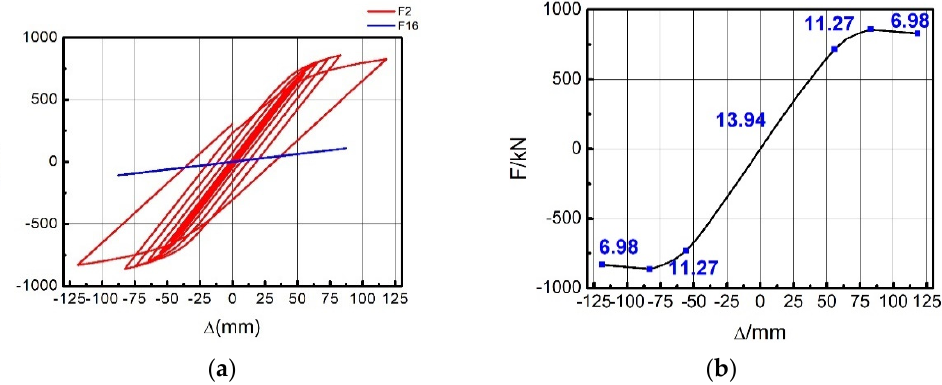
Figure 13. Hysteresis curves and the skeleton curve of frame F2. ( a ) Hysteresis curves of F2 and F16; ( b ) skeleton curve of F2.